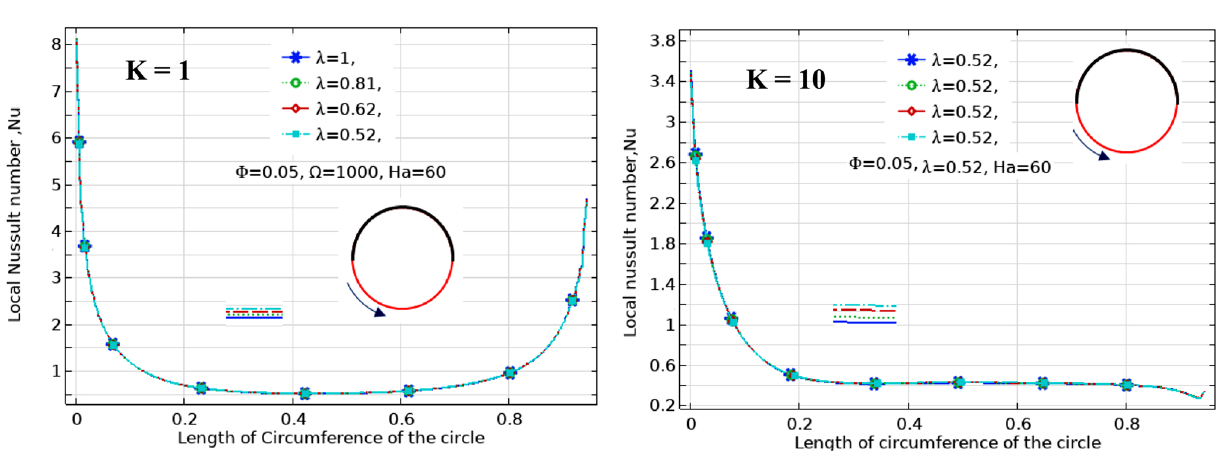
Figure 13. Local Nusselt number along contact arc for different NPs shapes at Ra = 10 6 , Ha = 60, Ω = 1000, and = ϕ